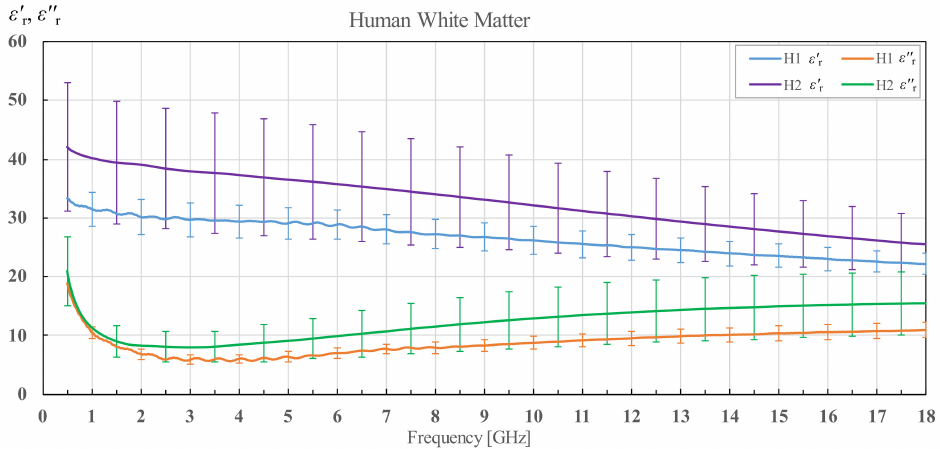
Figure 3. Permittivity of human white matter for brains H1 and H2 with corresponding standard deviations.